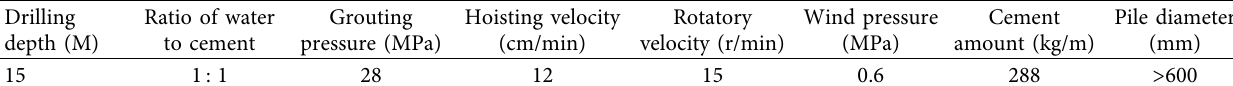
Table 2: The parameters of the test piles.